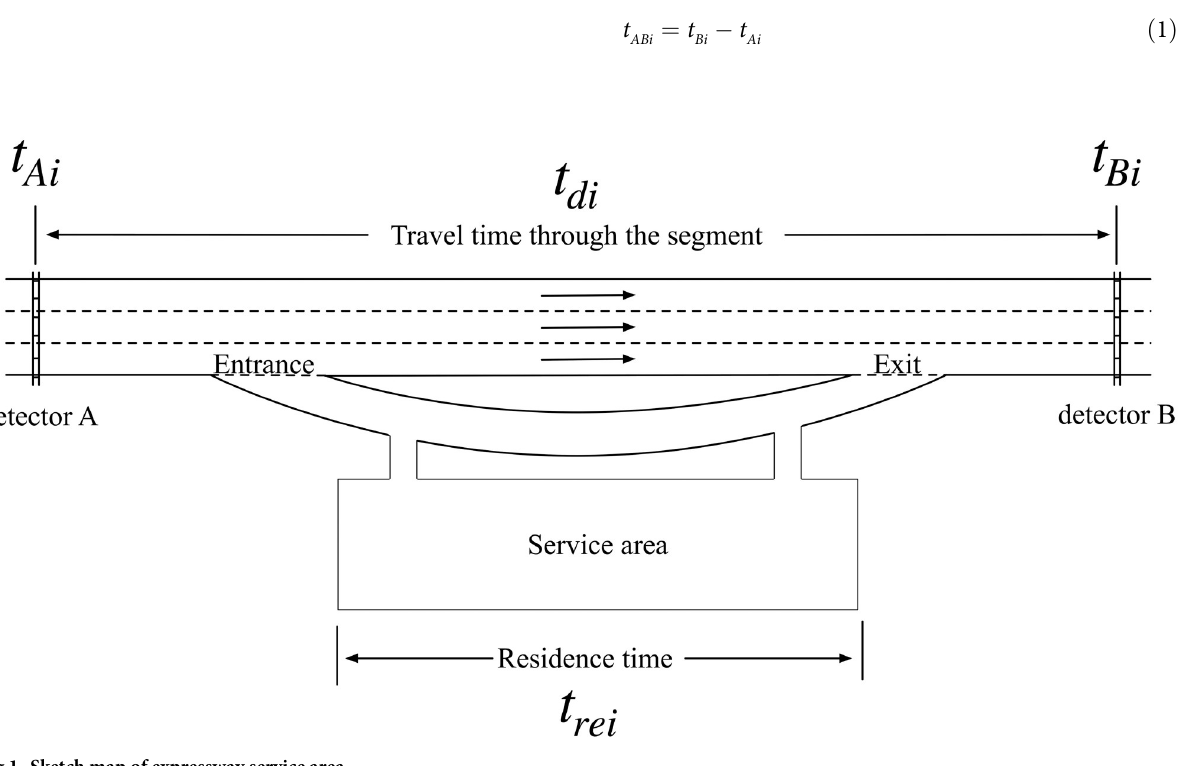
Fig 1. Sketch map of expressway service